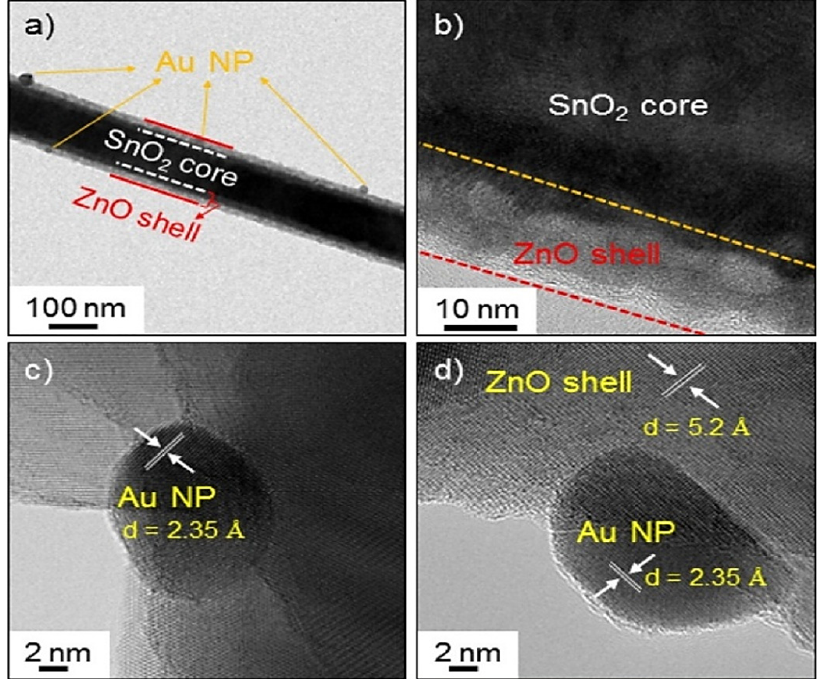
Figure 22. ( a ) TEM images of Au/SnO 2 -ZnO C-S NW, ( b ) HR-TEM image of SnO 2 -ZnO C-S NW, and ( c , d ) the corresponding HR-TEM images. Reproduced from [115] with the permission of Elsevier.